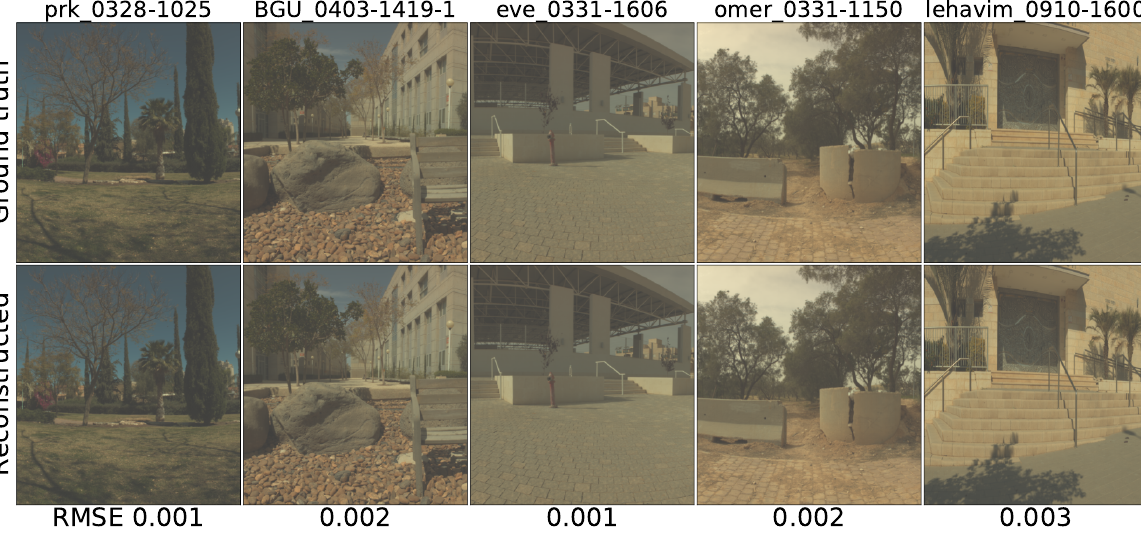
Figure 12. The effects of reconstructing the 5 chosen ICVL RGB images from the multispectral